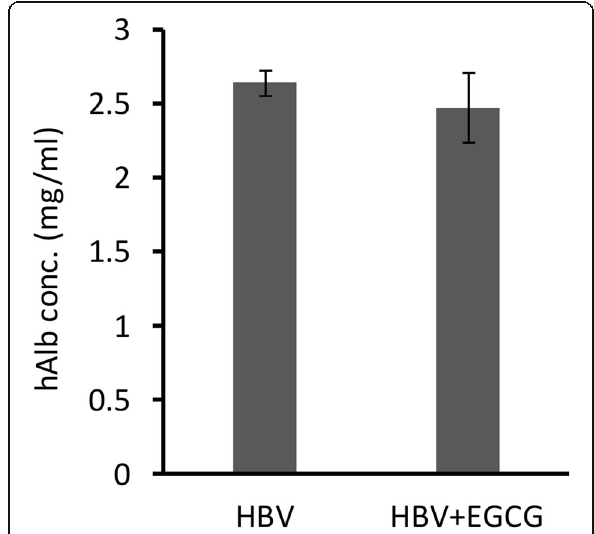
Fig. 2 Human albumin levels in Hu-FRG mice. The human albumin